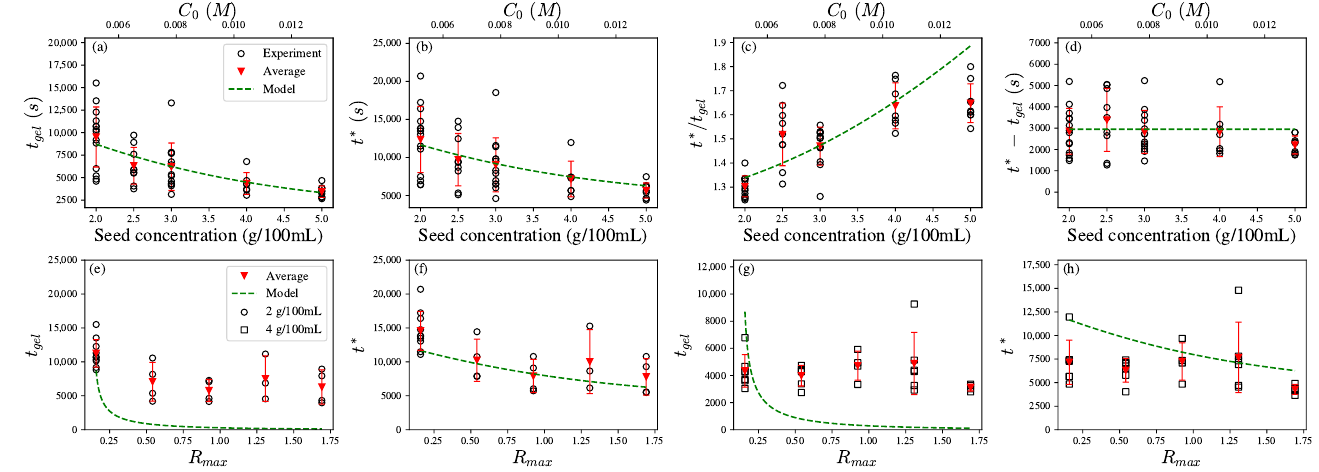
Figure 3. The measured and the predicted dependence of ( a ) t gel , ( b ) t ∗ , ( c ) t ∗ / t gel , and ( d ) t ∗ − t gel on the aiyu seed concentrations with the estimated R max = 0.158 in DI water, ( e ) t gel , ( f ) t ∗ on R max with the seed concentration = 2 g/100 mL, and ( g ) t gel , ( h ) t ∗ on R max with the seed concentration = 4 g/100 mL. The model captures the seed concentration dependency well in ( a – d ) while it fails to capture the R max dependency in ( e – h